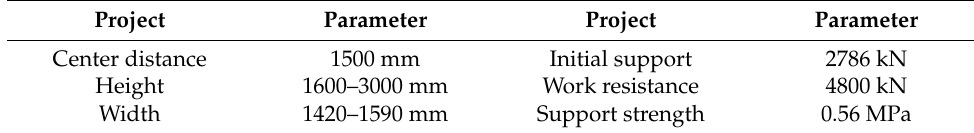
Table 2. Main technical parameters of ZC4800/16/30 backfilling hydraulic support.